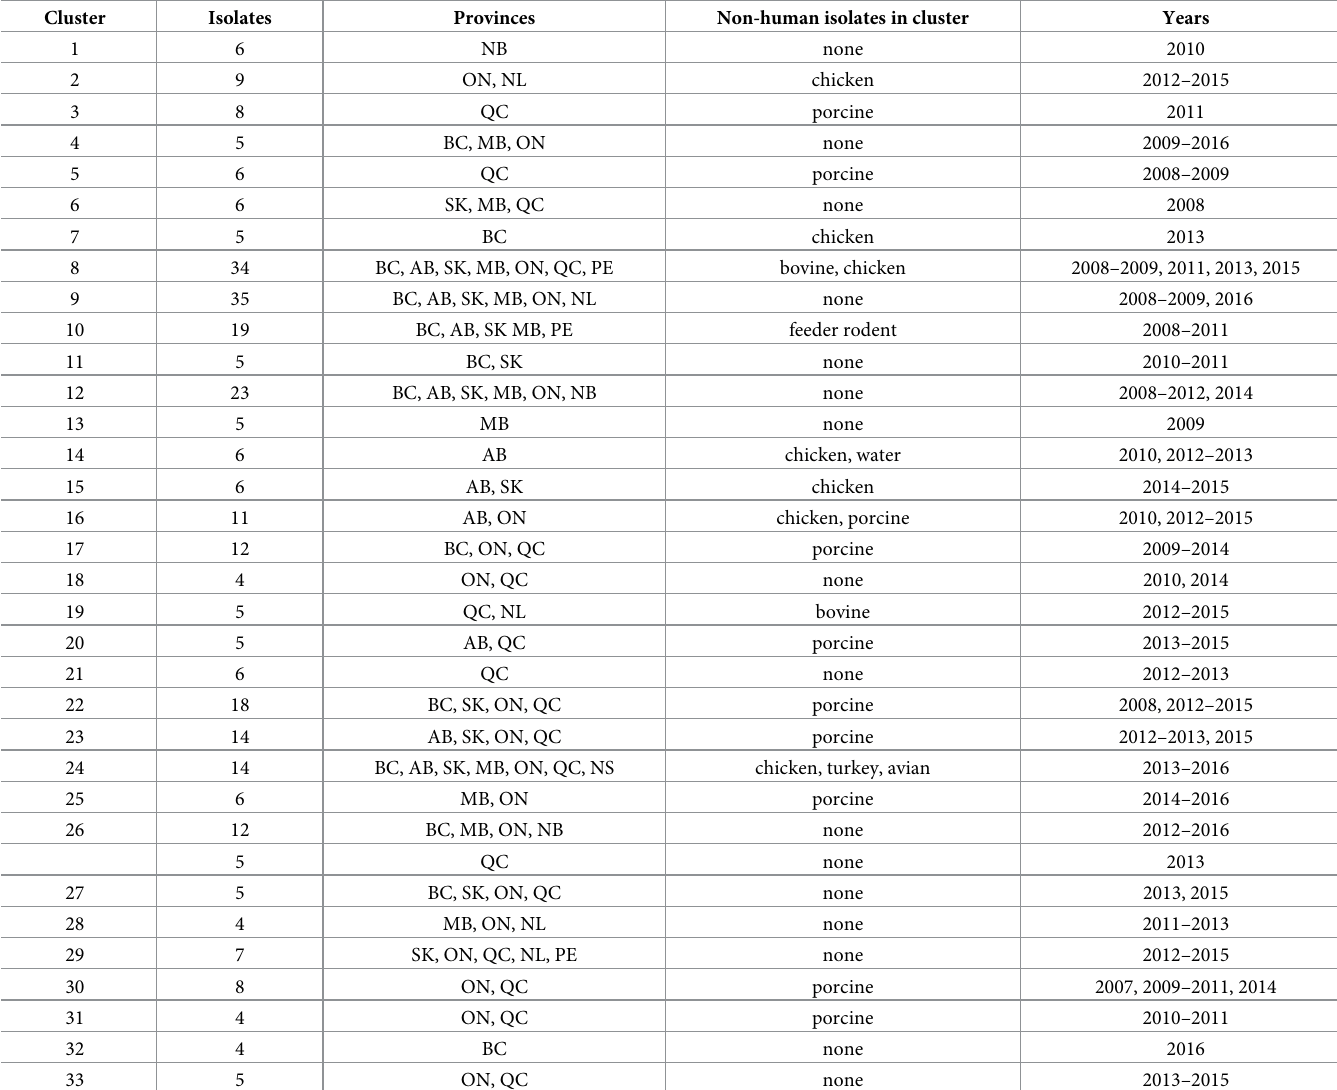
Table 1. Description of wgMLST UPGMA